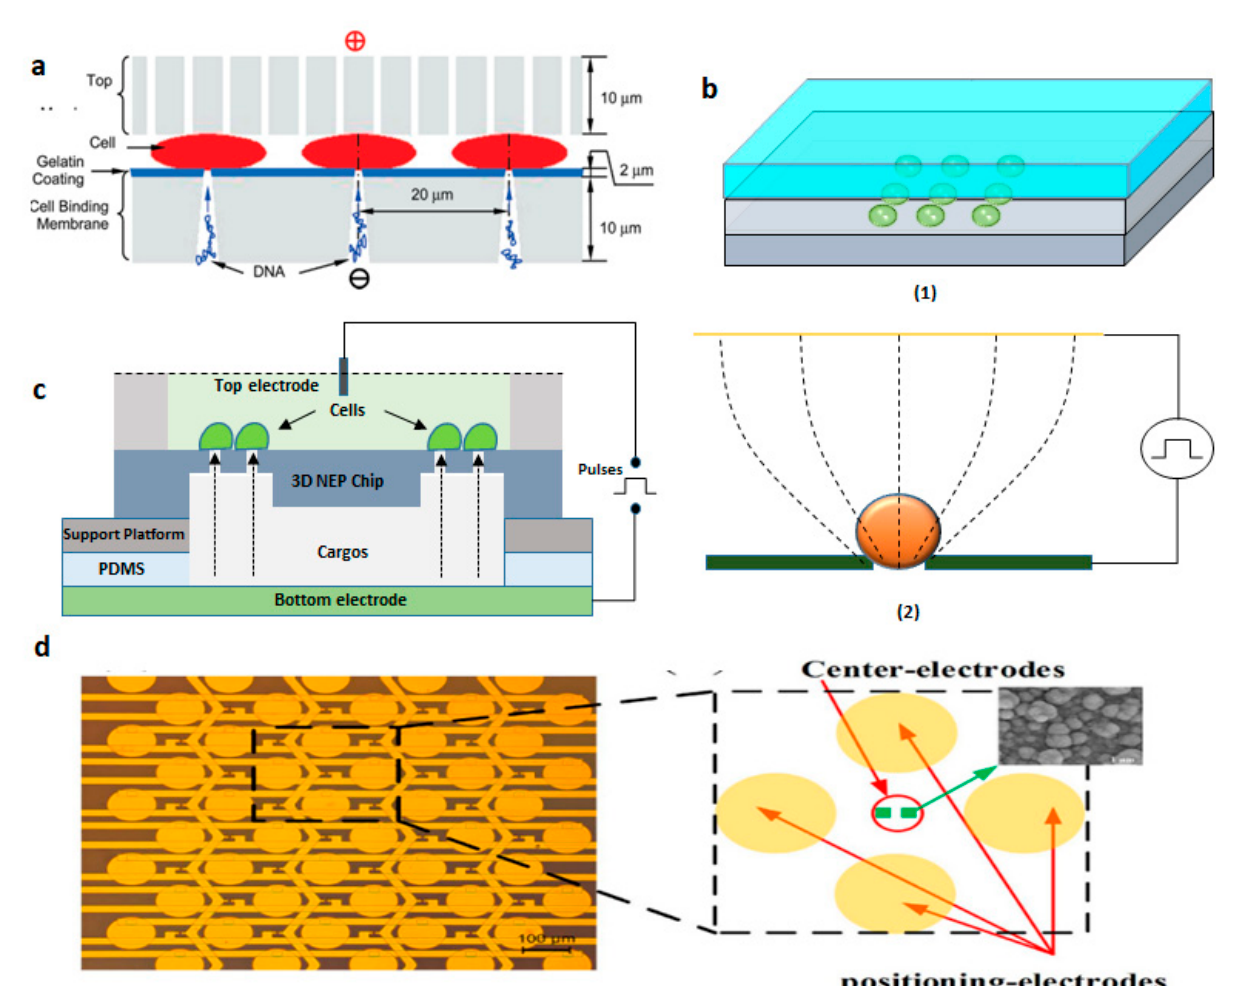
Figure 17. ( a ) Schematic of MSE disk setup. Reprinted with permission from ref. [121]. Copyright © 2010 American Chemical Society ( b ) ( 1 ) DEP device configuration and ( 2 ) The principle of electroporation. Figure has been redrawn from ref. [122]. Copyright © 2010 IEEE ( c ) Schematic of 3D Nanoelectroporation device. Figure has been redrawn from ref. [123]. Copyright © 2010 The Royal Society of Chemistry ( d ) Device design of the micro-electrode array chip. Reprinted with permission from ref. [125]. Copyright © 2016 Xiaoliang Guo et al.